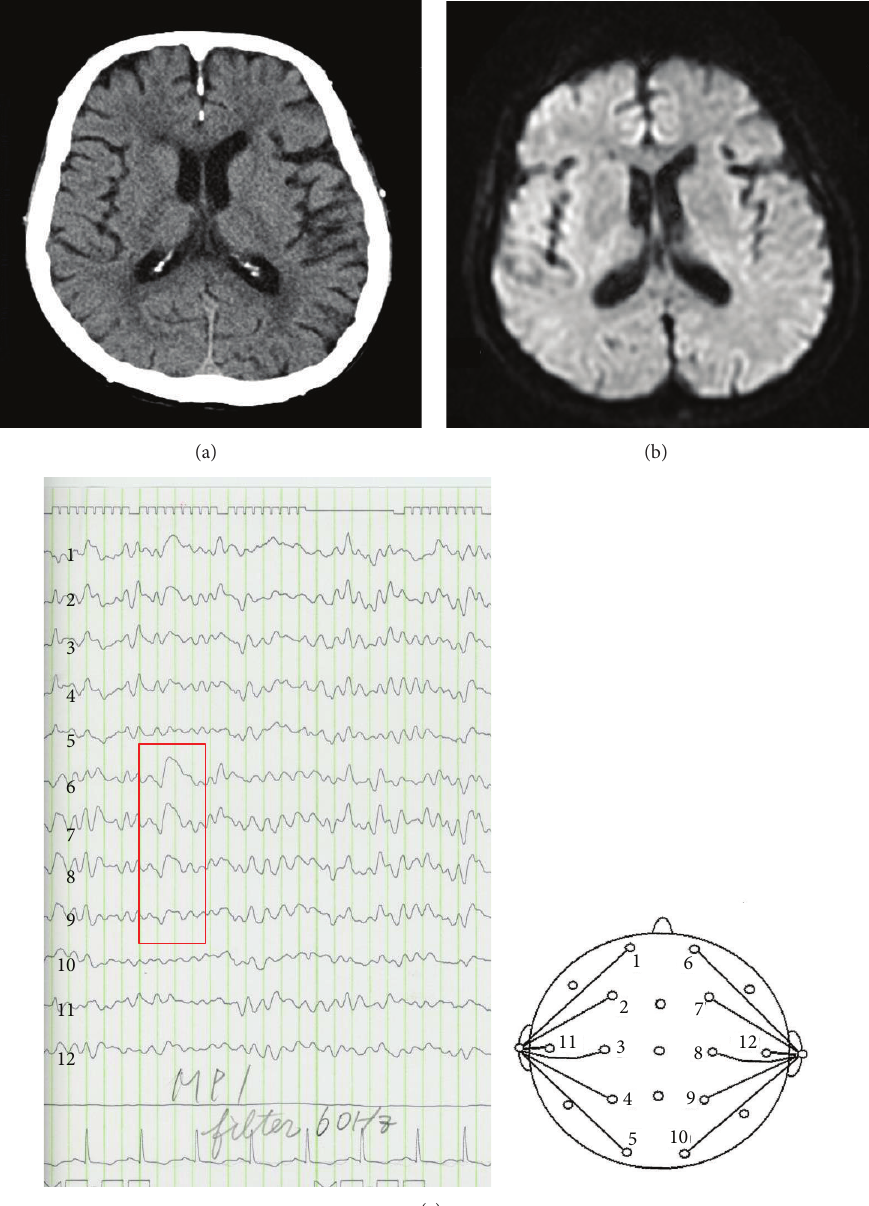
Figure1:Case1.Braincomputedtomography(CT)andmagneticresonanceimaging(MRI)onadmission.BrainCTshowednoacutecerebral bleeding (a). Brain MRI showed no acute cerebral infarction (b). Electroencephalography after admission showed repetition of intermittent high-amplitude irregular slow waves in the right frontal lobe (c). ∗ Lead placement: 1, left frontal pole (Fp1); 2, left frontal (F3); 3, left central (C3); 4, left parietal (P3); 5, left occipital (O1); 6, right frontal pole (Fp2); 7, right frontal (F4); 8, right central (C4); 9, right parietal (P4); 10, right occipital (O2); 11, left mid temporal (T3); 12, right mid temporal